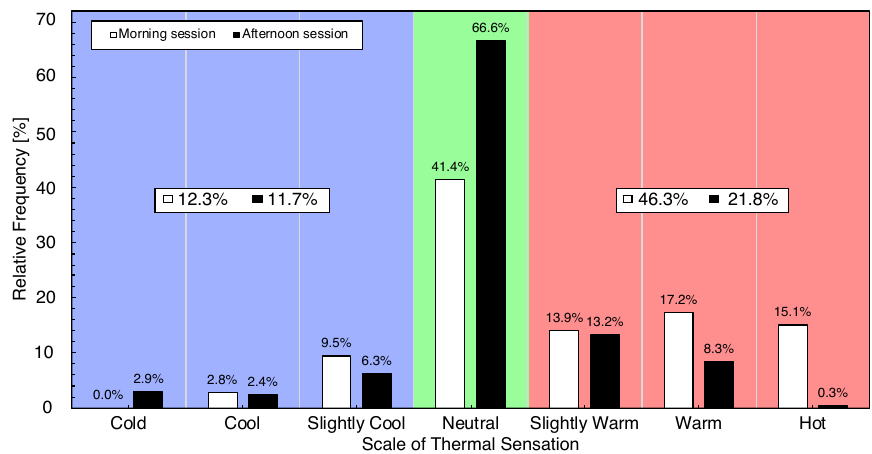
Figure 7. Subjective Comfort Level represents air speed against operative temperature.